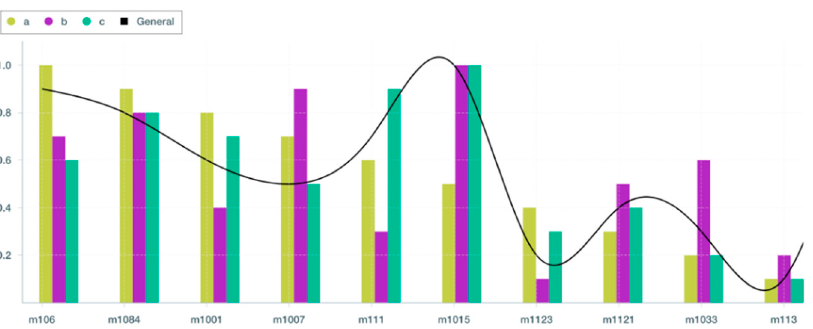
Figure 9. Rank of top resources selected for Task 334016 with varying weight preferences.